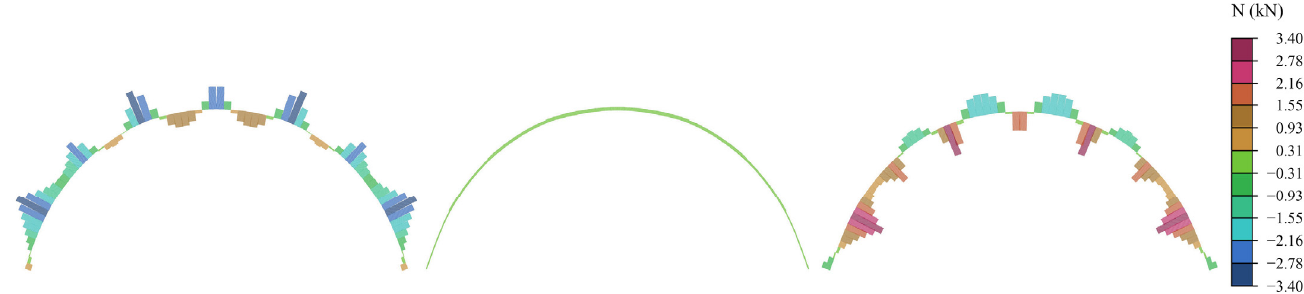
Figure 17. Transverse lath before relaxation of the structure ( Stage 4 ) in black, and deformed shape after relaxation in blue (amplification factor = 40).